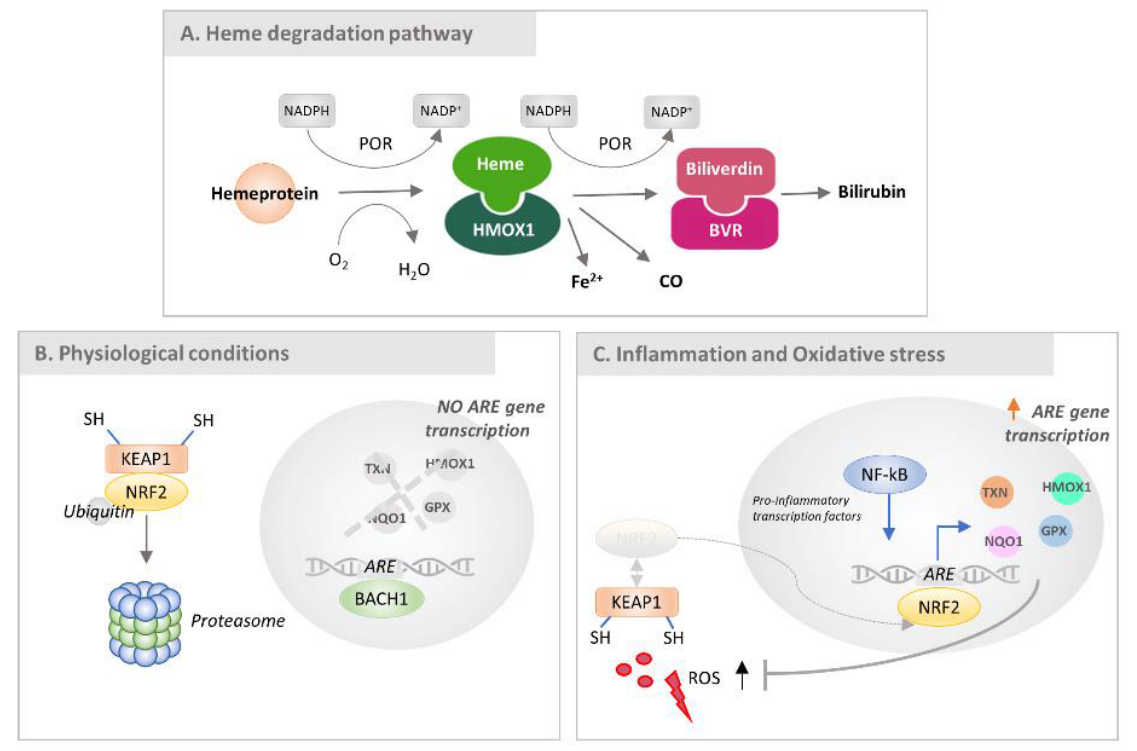
Figure 11. Signaling pathways in which HMOX1 is involved. ( A ) Heme degradation pathway promoted by HMOX1 occurring in the cytosol of the cell. Heme degradation occurs in the cytosol by the enzyme HMOX1; the reaction involves cytochrome P450 reductase, NADPH as cofactor and O 2 , leading to the production of NADP + , and an equimolar amount of biliverdin, carbon monoxide and iron (Fe 2+ ). Specifically, biliverdin can be further converted to bilirubin by the enzyme biliverdin reductase (BVR). ( B ) Regulation of HMOX1 expression under homeostatic conditions. NRF2 is bound to KEAP1, ubiquitinated and targeted for proteasomal degradation. BACH1 binds the antioxidant response element (ARE) at the promoter of HMOX1, inhibiting transcription of the gene. ( C ) Regulation of HMOX1 expression during inflammation and oxidative stress. Increased intracellular heme levels lead BACH1 to dissociate from ARE, and reactive oxygen species (ROS), interacting with cysteine residues on KEAP1, cause dissociation from NRF2, which in turn migrates into the nucleus, binds ARE and promotes transcription of HMOX1 (adapted from [67]).